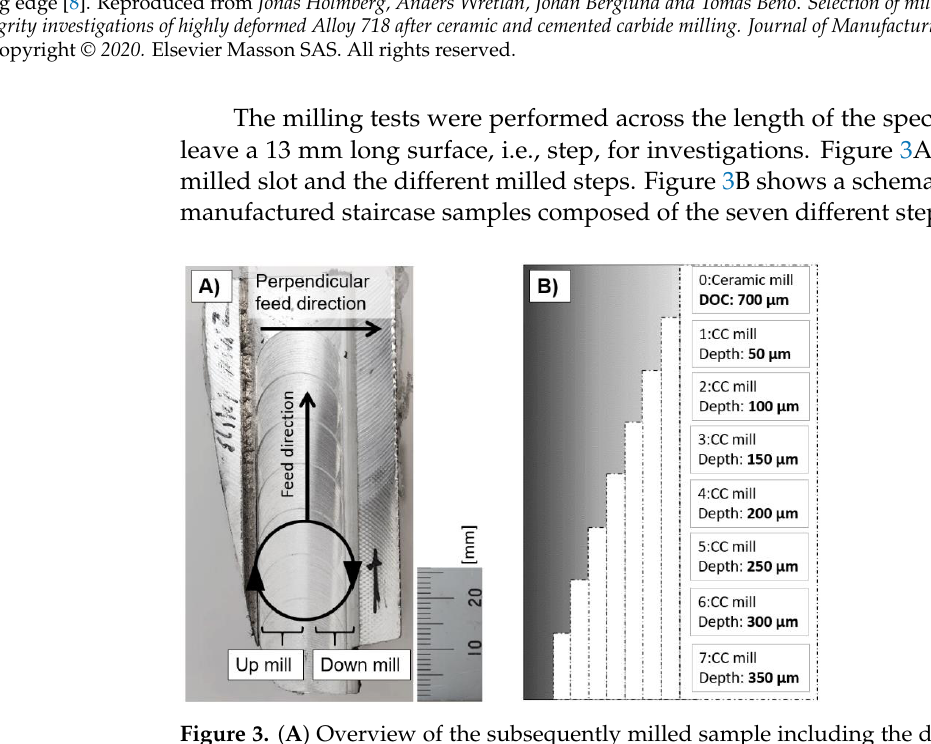
Figure 3. ( A ) Overview of the subsequently milled sample including the definition of the milling and orientation. ( B ) Schematic side view of the different milling steps performed on the sample, CC-Cemented